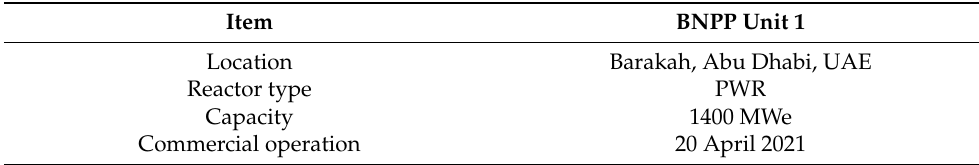
Table 1. Specifications of Barakah unit